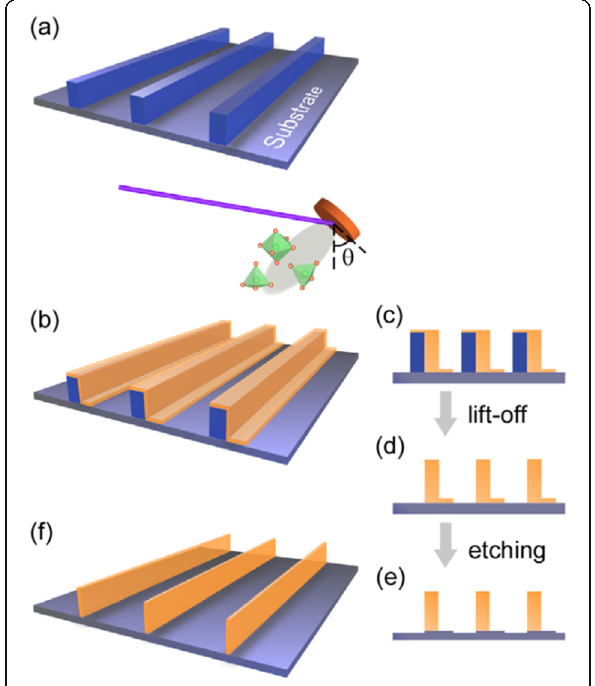
Fig. 1 Schematic flowchart of the 3D nano-template PLD method for perovskite oxide nanostructure fabrication. a First, template wall structures are patterned onto substrate by NIL using an organic resist (blue region). b Functional perovskite oxides (orange region) is then deposited onto the side surface of the template patterns by PLD. c Cross-sectional image of ( b ). Cross-sectional images for nanowall-wire structure after d liftoff and e etching. f Finally, self- standing perovskite oxide nanowall-wire arrays are obtained. Reproduced with permission of [144]